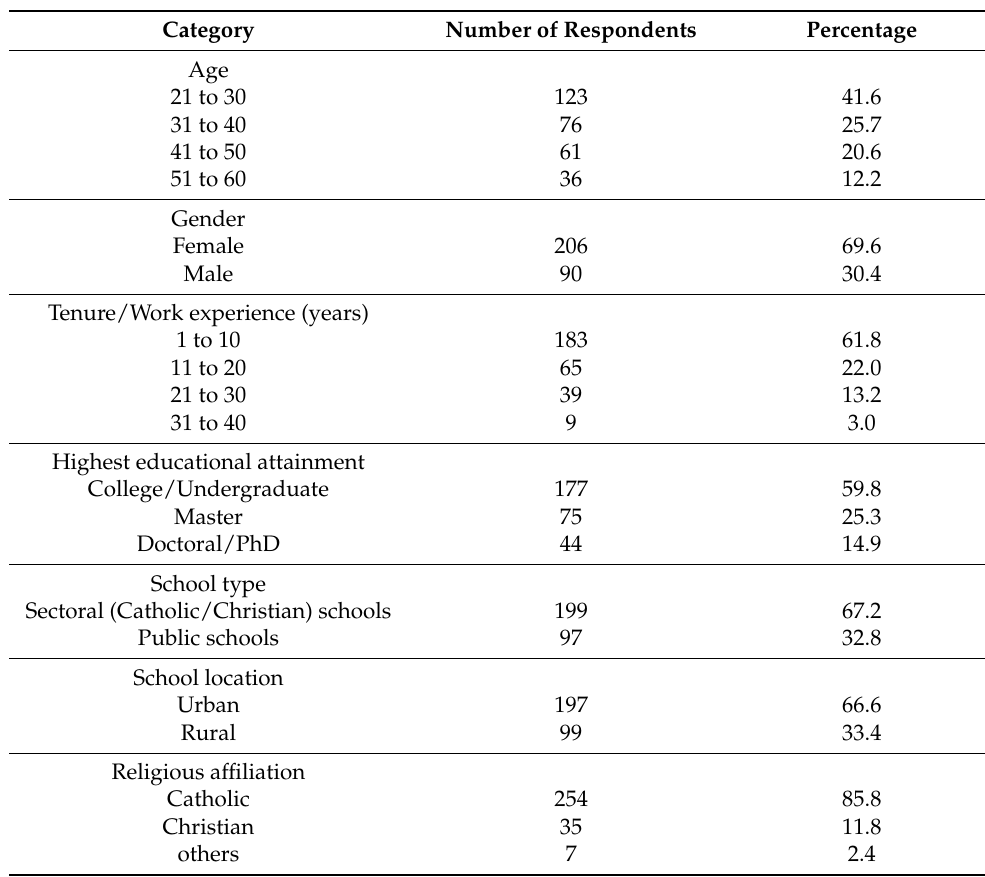
Table 1. Participants’ background